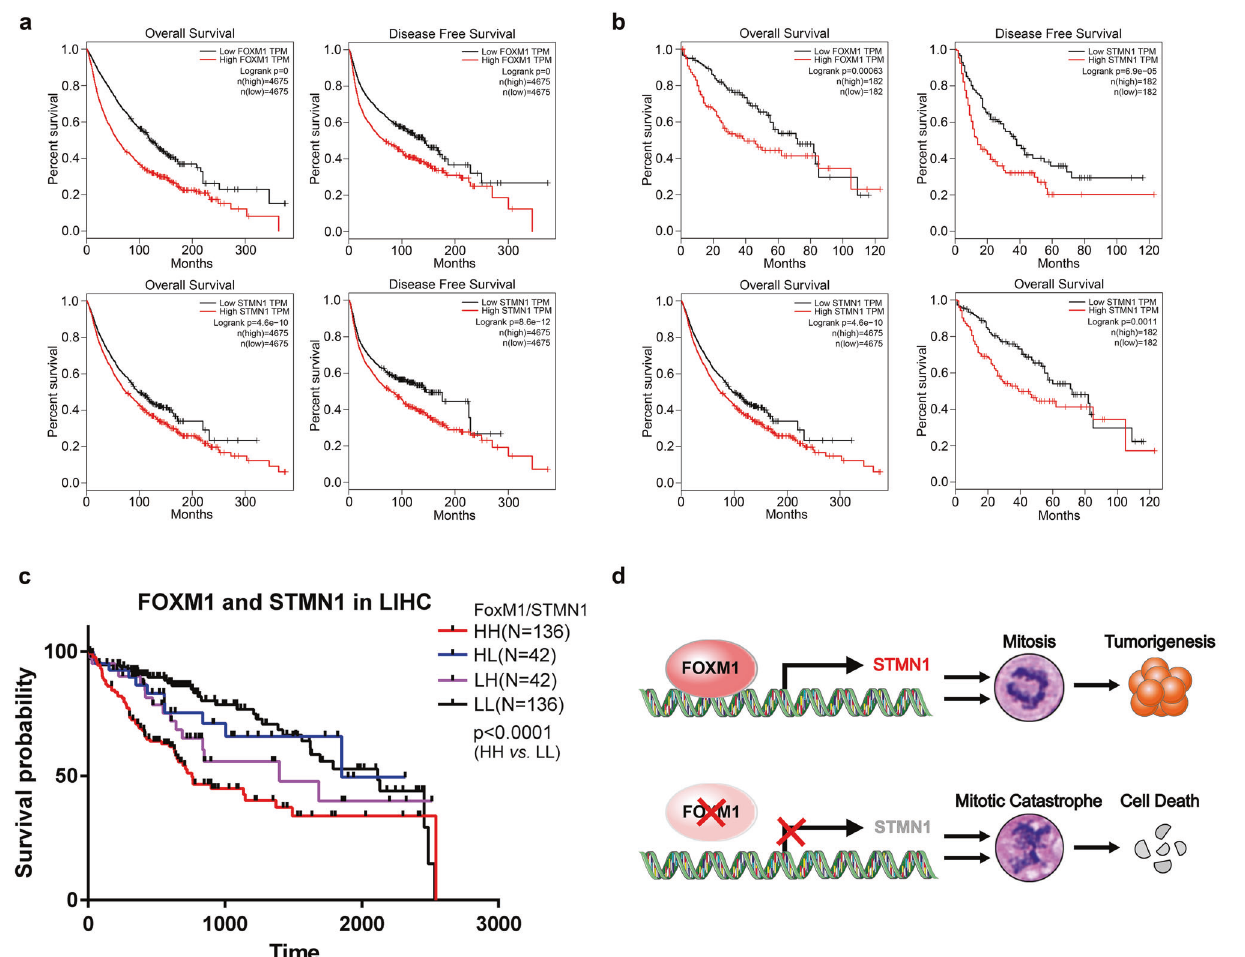
Fig. 6 High activation of FoxM1 – STMN1 signal axis is a risk of poor prognosis in cancers. a Overall survival and disease-free survival rate of 31 solid tumors (including ACC, BLCA, BRCA, CESC, CHOL, COAD, ESCA, GBM, HNSC, KICH, KIRC, KIRP, LGG, LIHC, LUAD, LUSC, MESO, OV, PAAD, PCPG, PRAD, READ, SARC, SKCM, STAD, TGCT, THCA, THYM, UCEC, UCS and UVM) from TCGA database were analyzed using the GEPIA platform; n = 9350. b Overall survival and disease-free survival rate of LIHC from TCGA database were analyzed using the GEPIA platform; n = 364. c Overall survival rate of LIHC from the TCGA database was analyzed according to the mRNA levels of FoxM1 and STMN1. HH, FoxM1 High / STMN1 High ( n = 136). HL, FoxM1 High /STMN1 Low ( n = 42). LH, FoxM1 Low /STMN1 High ( n = 42). LL, FoxM1 Low /STMN1 High ( n = 136). d A working model showing that aberrantly high activation of FoxM1 – STMN1 axis contributes to tumorigenesis in cancer cells by promoting cell mitosis, while interruption of FoxM1 – STMN1 axis can result in mitotic catastrophe-mediated cell mitosis (Fig. 5d, e). To con fi rm its effect on tumor progression, we performed survival analysis of LIHC patients. Surprisingly, we found that not only patients bearing FoxM1 high or STMN1 high tumors have a low survival, but patients bearing FoxM1 high / STMN1 high tumors have the highest risk of poor prognosis, as the data shown in Fig. 6c. It indicates that LIHC overexpressing both FoxM1 and STMN1 is more aggressive, thus shedding light on the prognostic role of combined use of FoxM1 and STMN1. Though the positive correlation between high STMN1 expres- sion and poor prognosis of GC and CRC patients is not as apparently as that in LIHC, there is a trend that GC or CRC patients bearing highly STMN1-expressed tumor have poor prognosis (Supplementary Fig. S5). It may because that dynamic changes in the phosphorylation level of STMN1 is the main event of mitotic process besides the transcription of mRNA. Another reason might be the drug resistance of high STMN1 expression patients.